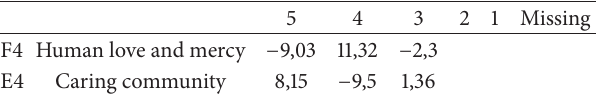
Table 3: Effects on distribution function when C2 fixed to “4” = 100%.